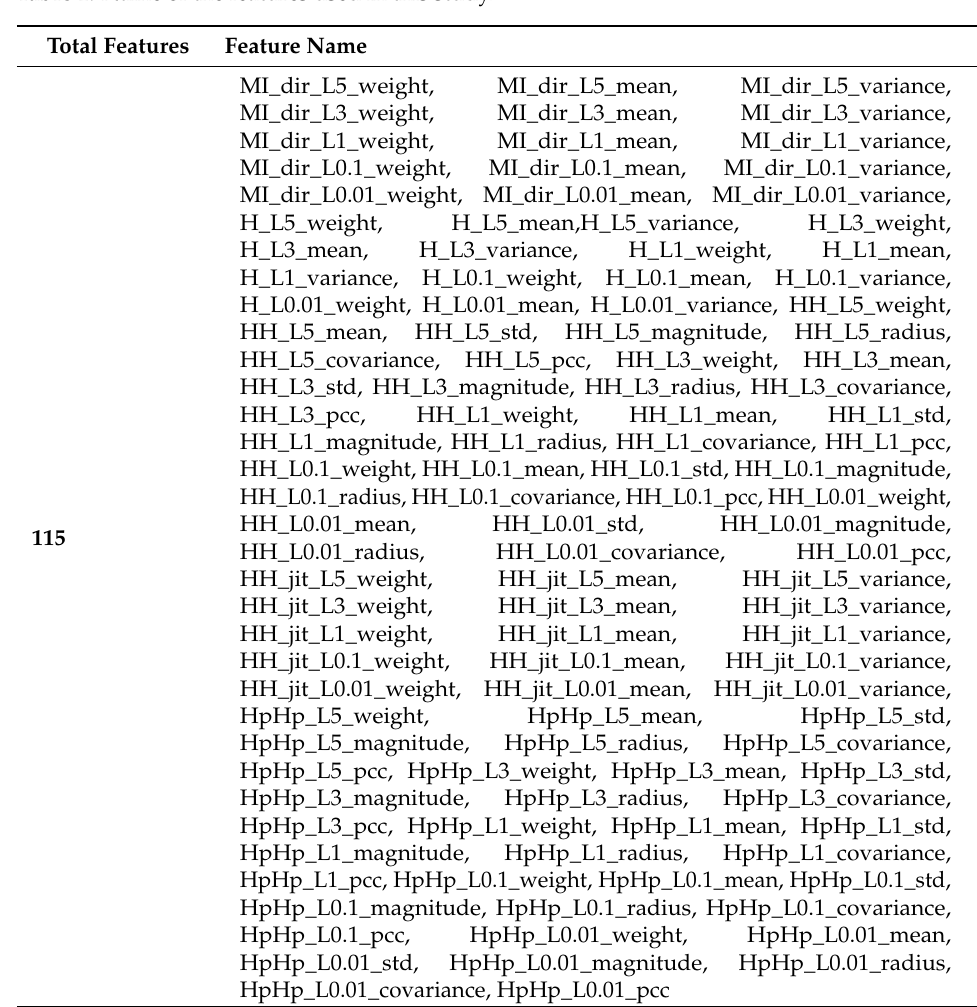
Table 1. Name of the features used in this study.